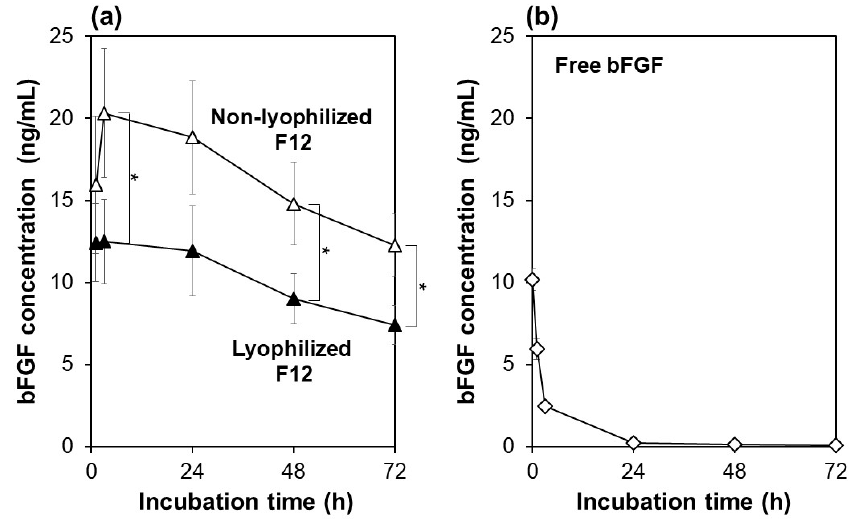
Figure 3. Variations of bFGF concentration with incubation time up to 72 h in the acellular medium supplemented with ( a ) the non-lyophilized (white triangles) or lyophilized (black triangles) F12 membrane, or ( b ) 10 ng/mL of free bFGF (average ± SD; n = 3; * p < 0.05).